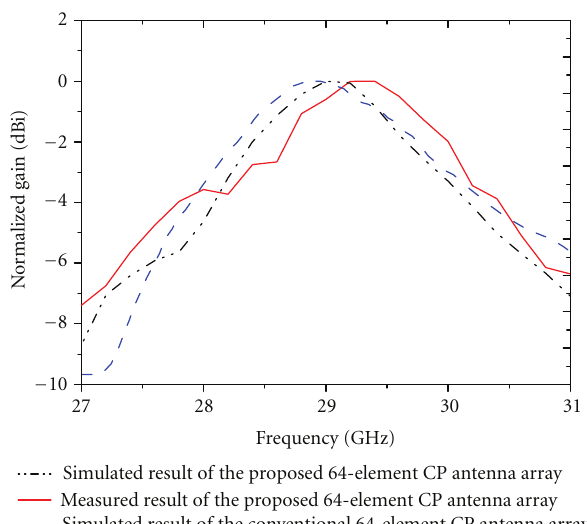
Figure 13: Measured and simulated gain of the 64-element CP antenna